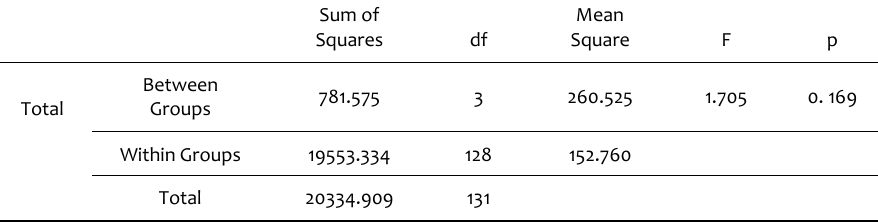
Table 9. Students' reading motivation scores in relation to the number of books read per year